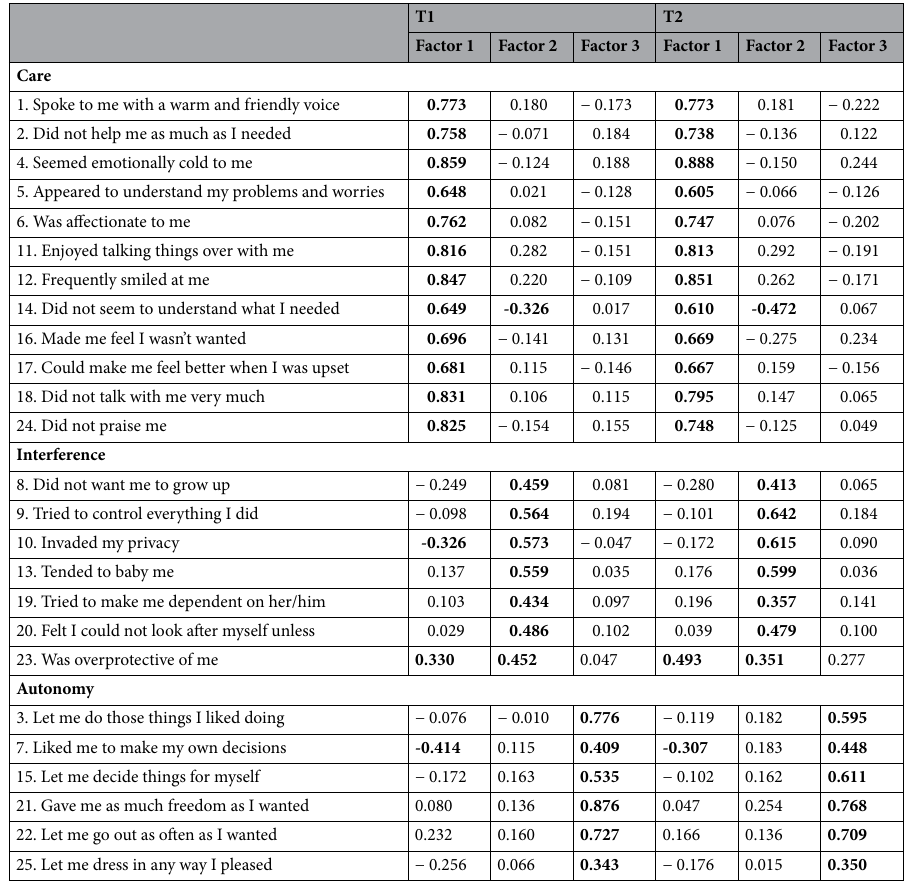
Table 3. Factor matrix of the Parental Bonding Instrument after rotation (Fathers). Factors that satisfy the factor loading > 0.3 after factor analysis are shown in bold. T1: at 25 weeks of gestation; T2: at 1 month